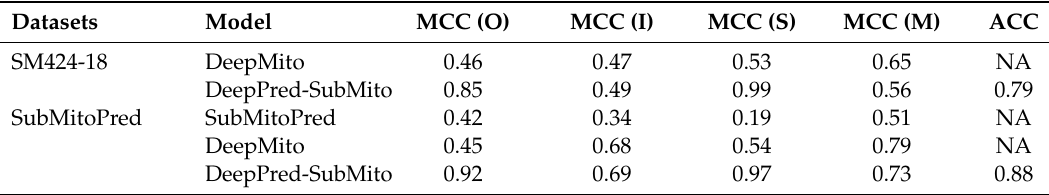
Table 3. Performance comparison of di ff erent